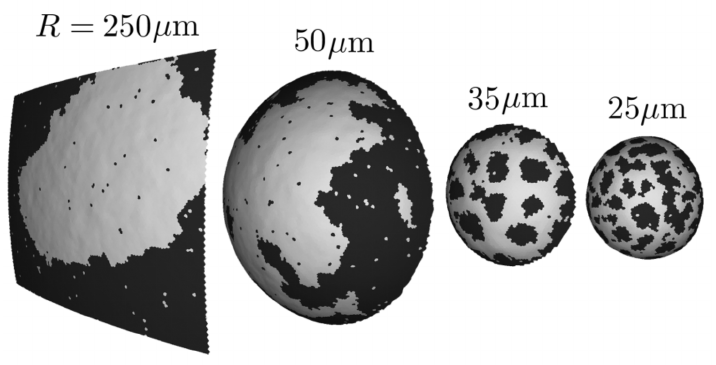
Figure 6. From right to left, the vesicle radius of curvature (written above each snapshot) is increased while the total area of the patch is held fixed. Above a critical curvature, there is a transition from a Lo/Ld mesophase to a macrophase separation. Reproduced from [128], with permission from the American Physical Society, Copyright